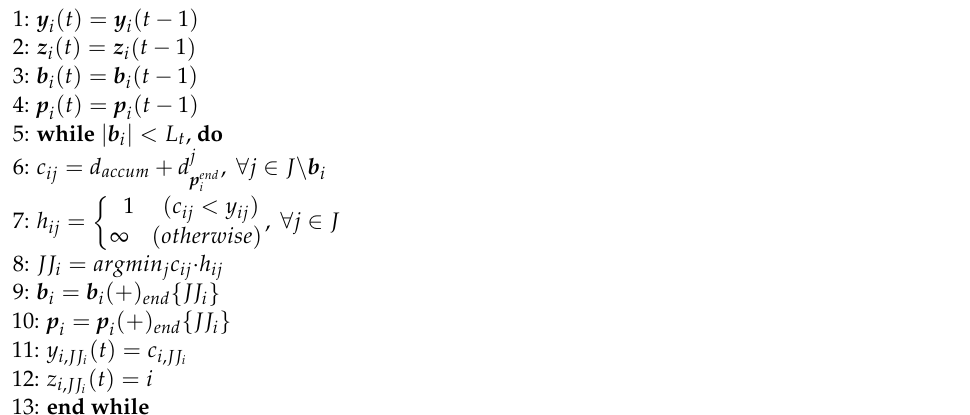
Algorithm 3 CBBA Phase 1: Bundle construction for Accumulated Distance Cost